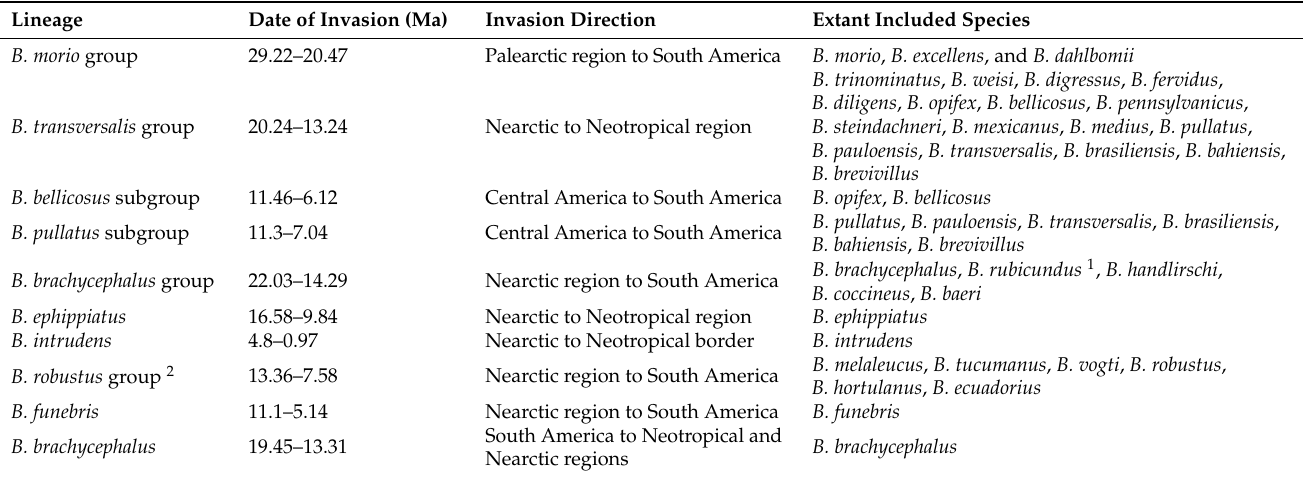
Table 1. Date of invasion, invasion directions, and included extant species of the main Neotropical and South American lineages of Bombus , as recovered in the phylogenetic and biogeographic analyses. Names employed for the lineages are mainly those of https://www.nhm.ac.uk/research-curation/ research/projects/bombus/subgenericlist.html, accessed on 3 March 2017. Discrepancies between William’s nomenclature and our lineages are indicated.